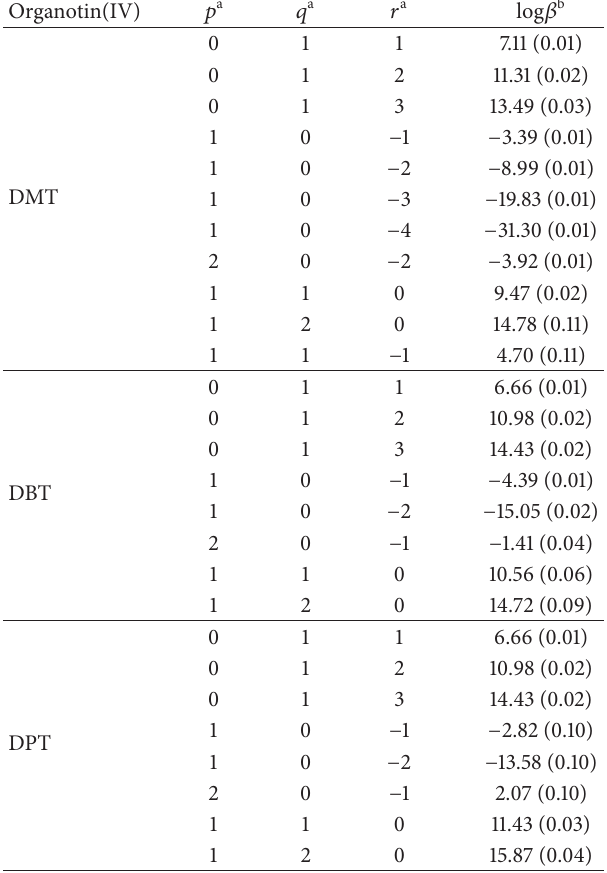
Table 1: Formation constants of organotin(IV) complexes with 3,3- bis(1-methylimidazol-2-yl)propionate in water for DMT and in 50% (v/v) dioxane-water solution for DBT and DPT, at 25 ∘ C and 0.1M ionic